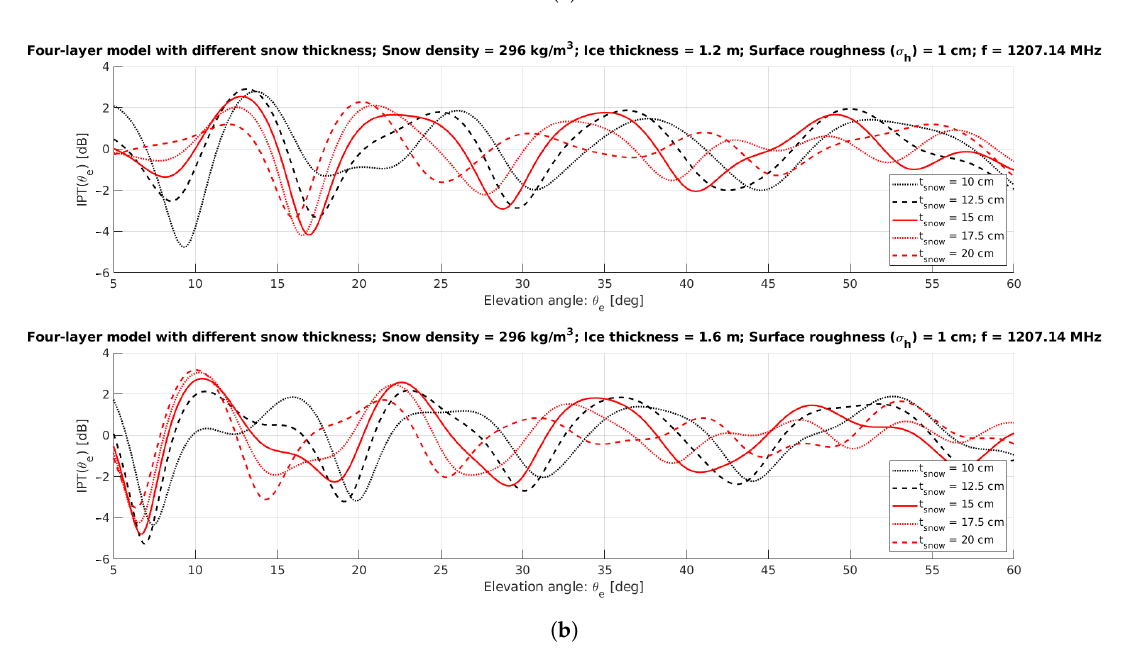
Figure 7. Four-layer model at LHCP for five different snow thickness, at two predefined ice thickness, 1.2 m (top), and 1.6 m (bottom). Simulation at 1575.42 MHz ( a ) and 1207.14 MHz ( b ). Assuming a surface roughness of 1 cm.